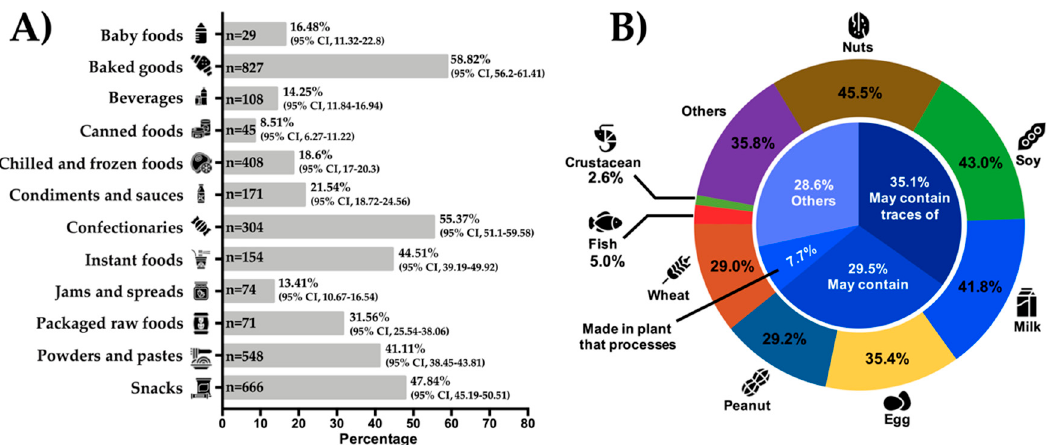
Figure 3. Percentages of packaged foods with precautionary allergen labelling (PAL) and the